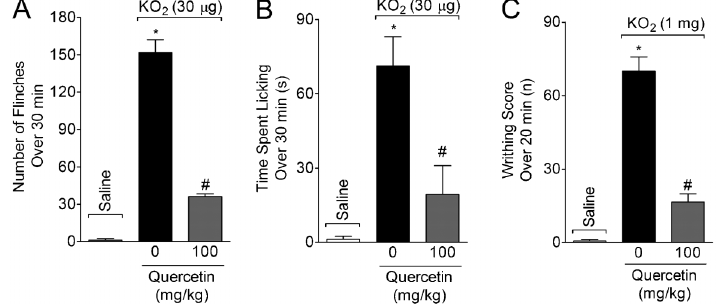
Figure 7. Quercetin inhibited the KO 2 -induced overt pain-like behaviors. Mice were treated with quercetin (100 mg/kg, ip ) or vehicle 1 h before stimuli. The number of paw flinches ( A ), and the time spent licking the paw ( B ) were quantified during 30 min after KO 2 (30 m g/paw) injection. The writhing score ( C ) was quantified during 20 min after KO 2 (1 mg, ip ) injection. Data are reported as means±SE. *P , 0.05 vs saline control; # P , 0.05 vs KO 2 control (one-way ANOVA followed by Tukey’s t